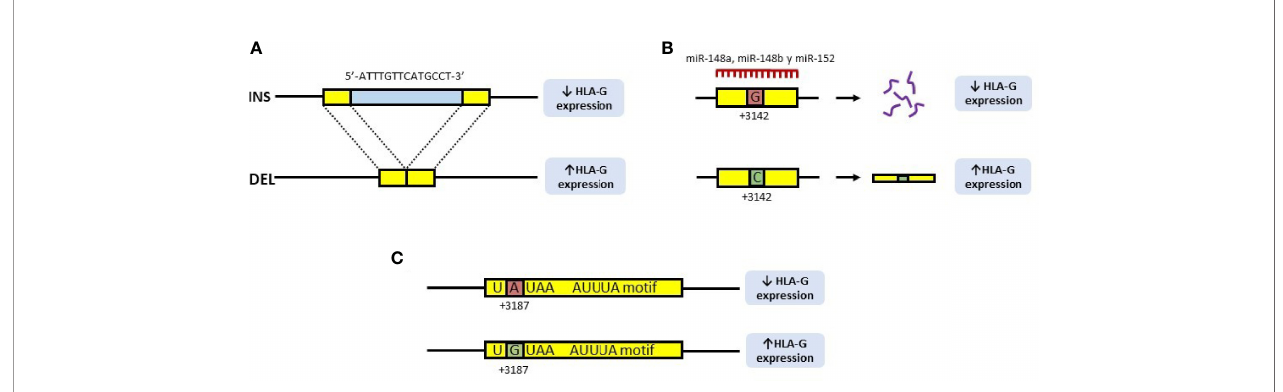
FIGURE 2 | Polymorphismsof the 3 ’ UTR region of the HLA-G gene involved inthe expression of the HLA-G molecule. (A) 14bp INS/DEL polymorphism ischaracterizedby the insertion (INS) ordeletion (DEL)ofa 14bp fragment at position +2960 of the HLA-G gene. Insertion isassociatedwith decreased expression ofHLA-G,due to a longer andunstable transcript, while deletion isassociated with increased expression. (B) In the +3142C/G polymorphism, the presence ofa guanine (G)atposition +3142 ofthe HLA-G gene increases the af fi nity of the microRNAs, miR-148a, miR148b and miR-152 for this region,thusdecreasing the availability ofthe mRNA. In contrast, the presence of a cytosine (C), produces an increase in theexpression of HLA-G. (C) In the +3187A/G polymorphism, the presence of an adenine(A) at this position modi fi es an AU-rich motifinthe gene mRNA, decreasing its stability,while G isassociated with an increase in HLA-G